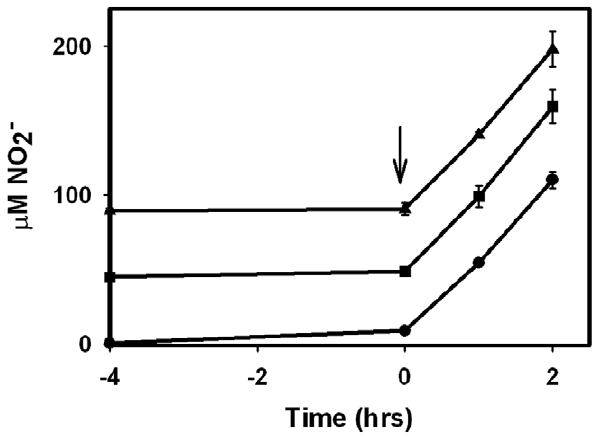
Figure 2. Effect of pretreatment with nitrite on nitrate reductase activity. M. tuberculosis was incubated anaerobically with 0, 50 or 100 m M NO 2 2 . After 4 hrs nitrate was injected and nitrite levels measured at time 0, 1 and 2 h. The arrow indicates the time of the addition of nitrate. Circles – control, no nitrite. Squares – with 50 m M NO 2 2 . Triangles – with 100 m M NO 2 2 . Standard deviation is shown.